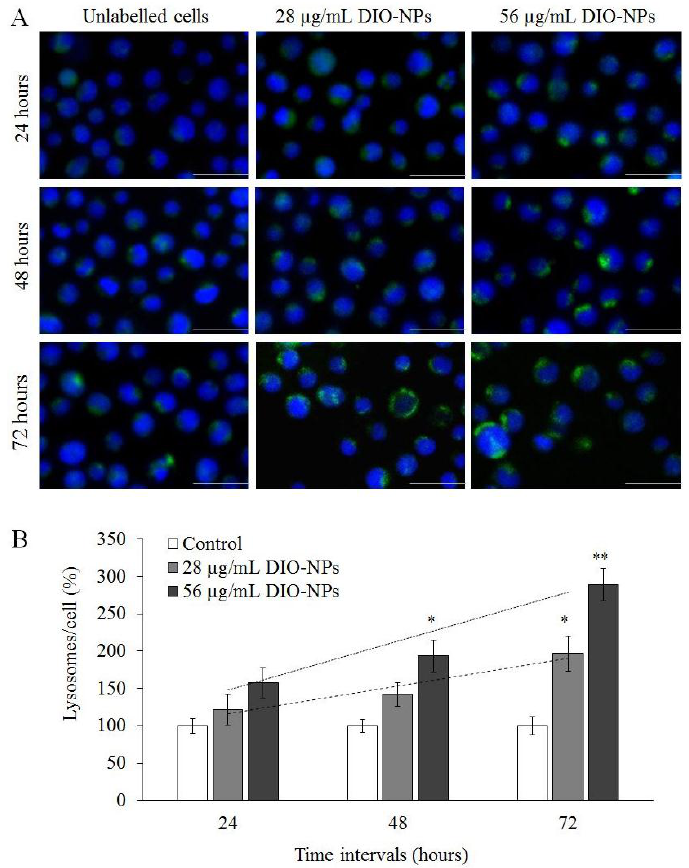
Figure 7. Localization and quantification of lysosomes in Jurkat cells treated with 28 and 56 µg/mL DIO-NPs after 24 h, 48 h, and 72 h. ( A ) Lysosomes (green color) were labeled with Lysotracker green DND-26 and nuclear DNA content with DAPI (blue color). Scale bar = 40 µm. ( B ) Quantification of lysosomal fluorescence intensity using ImageJ software. Lysosomal area over total number of cells from the selected field of view was calculated as the percentage of treated cells compared to the control and expressed as means ± SD ( n = 3/experimental group). * p < 0.05 vs. control; ** p < 0.01 vs. control.